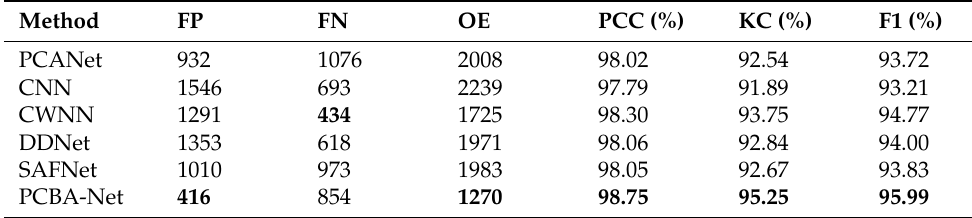
Figure 11. Visualization of comparative experimental results for the Ottawa dataset. ( a ) Ground-truth image. ( b ) Result of PCANet. ( c ) Result of CNN. ( d ) Result of CWNN. ( e ) Result of DDNet. ( f ) Result of SAFNet. ( g ) Result of the presented PCBA-Net. Table 2. Change detection results for Ottawa dataset.